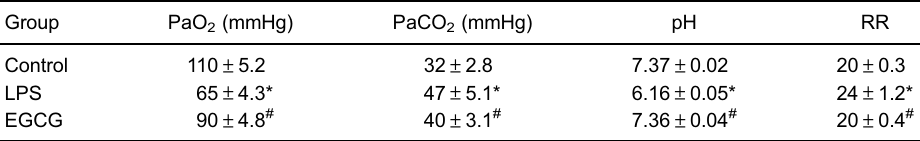
Table 2. Comparison of blood gas analysis of the three groups.